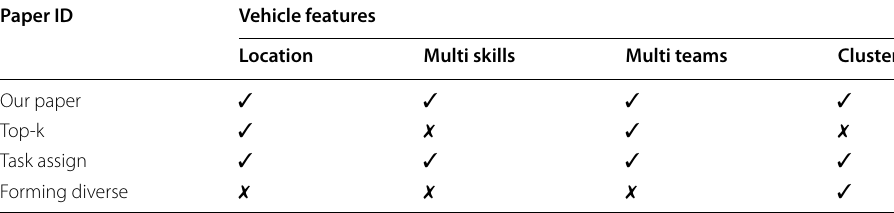
Table 2 Comparison of vehicle between our paper and other papers Paper ID Vehicle features Location Multi skills Our